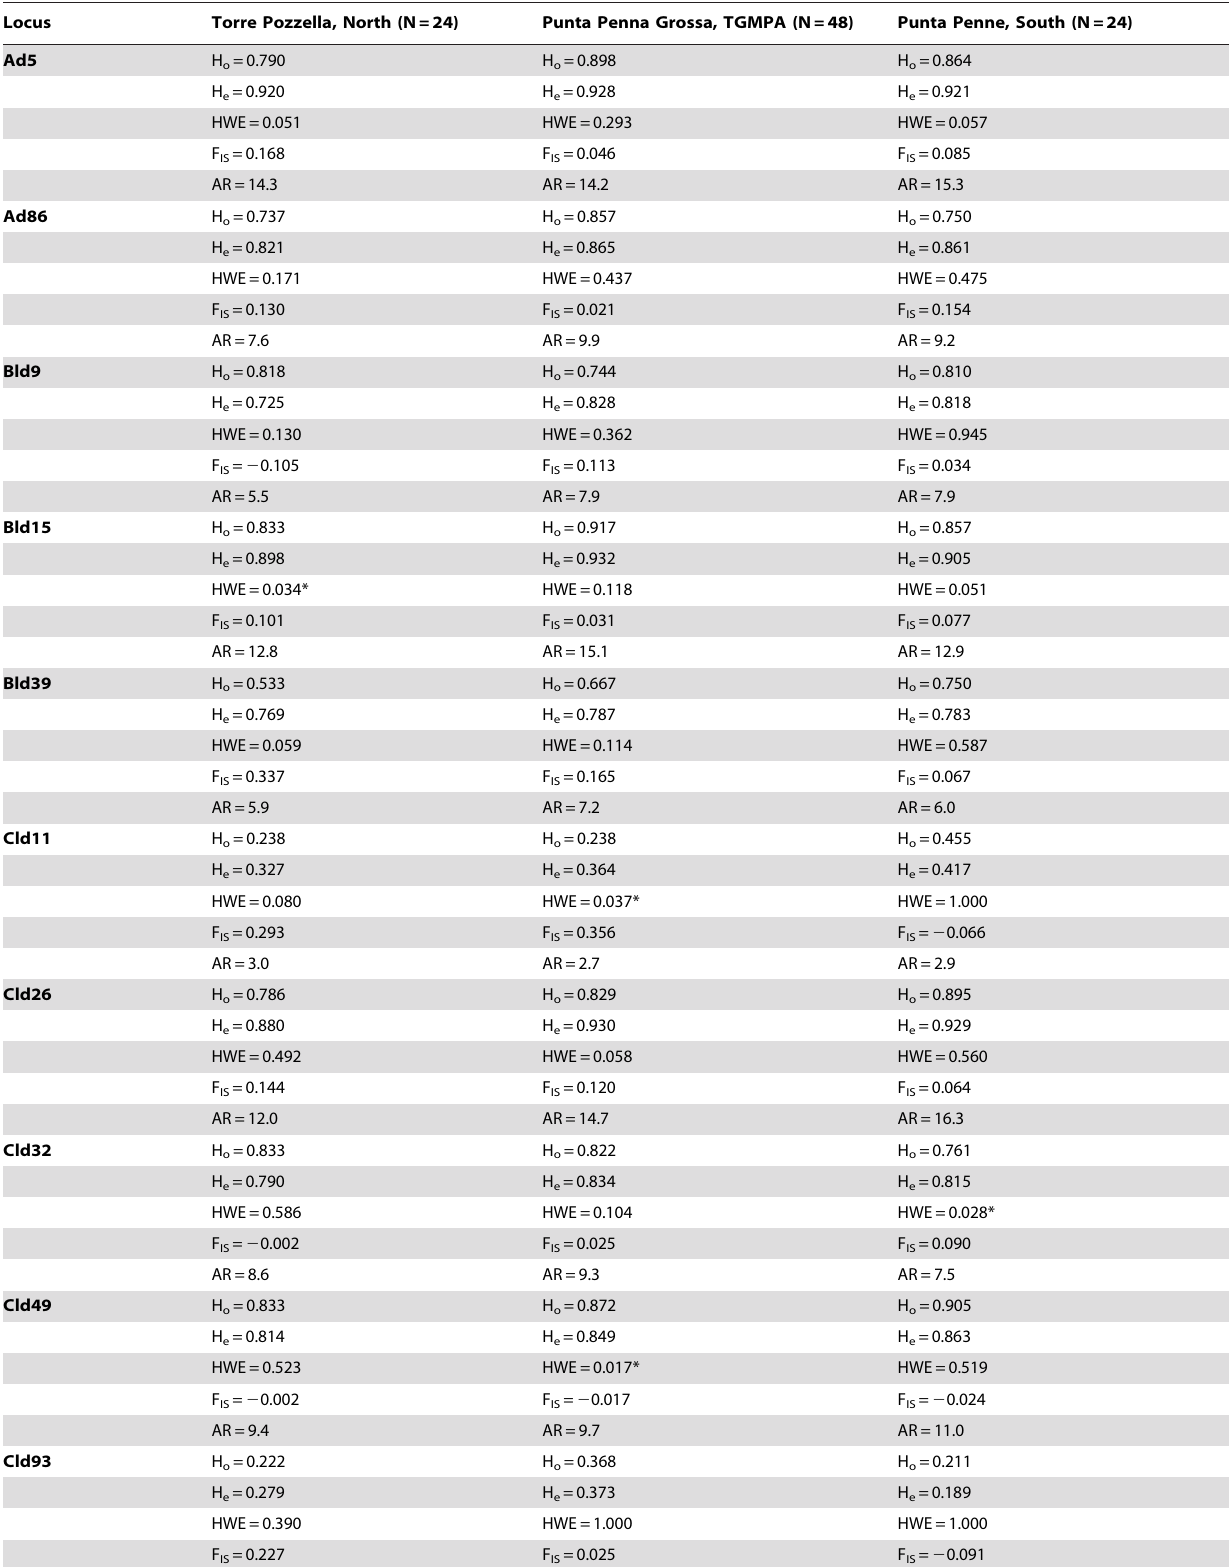
Locus Torre Pozzella, North (N=24) Punta Penna Grossa, TGMPA (N=48) Punta Penne, South